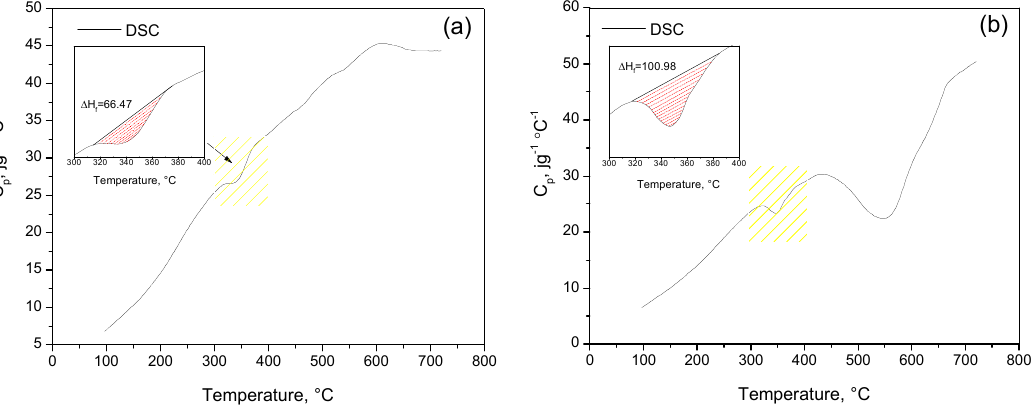
Figure 4. Heat capacity dependence on temperature for p-PGFPh:AA copolymers at initial ratios